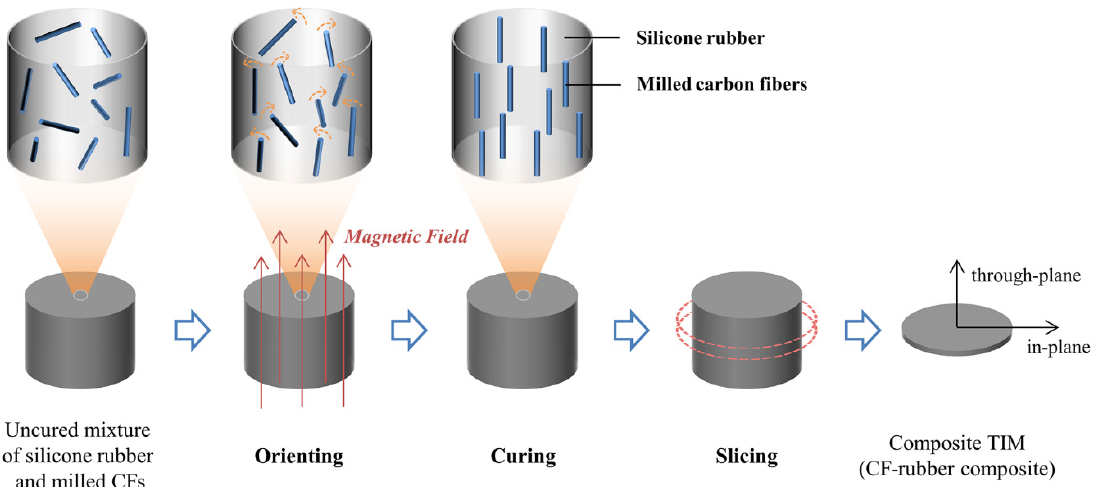
Figure 1. Schematic illustration of the preparation process of CF–rubber